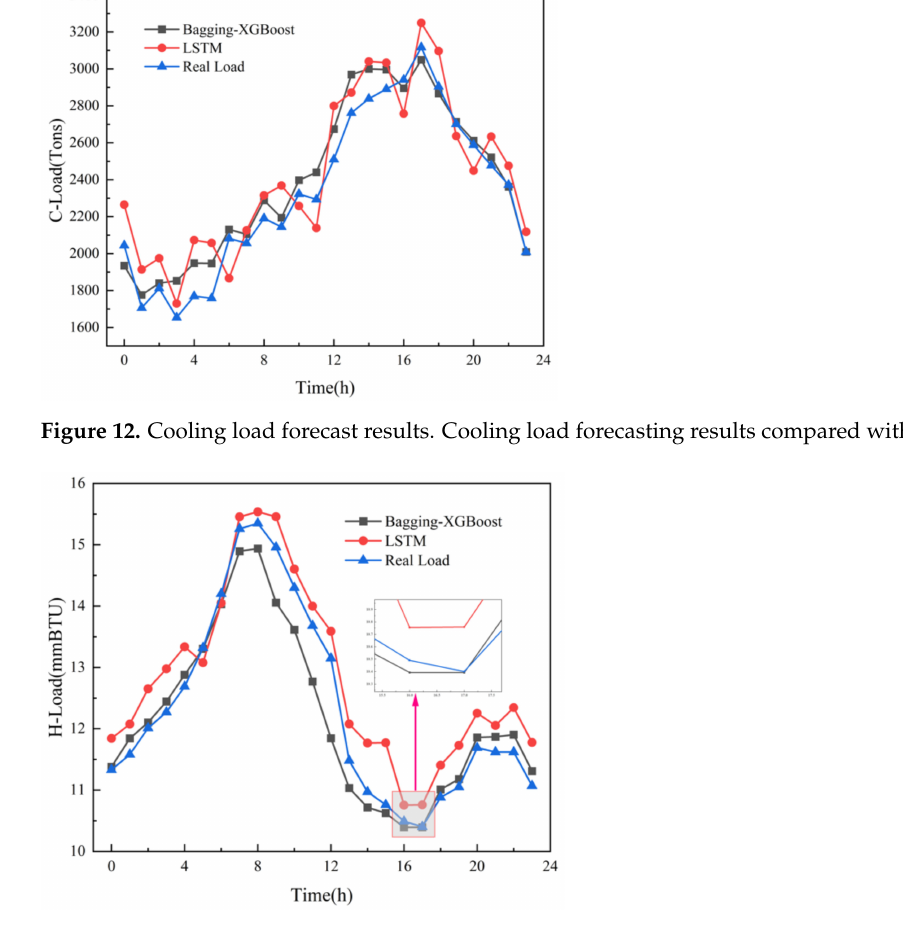
Figure 13. Heat load forecast results. Heat load forecasting results compared with LSTM.